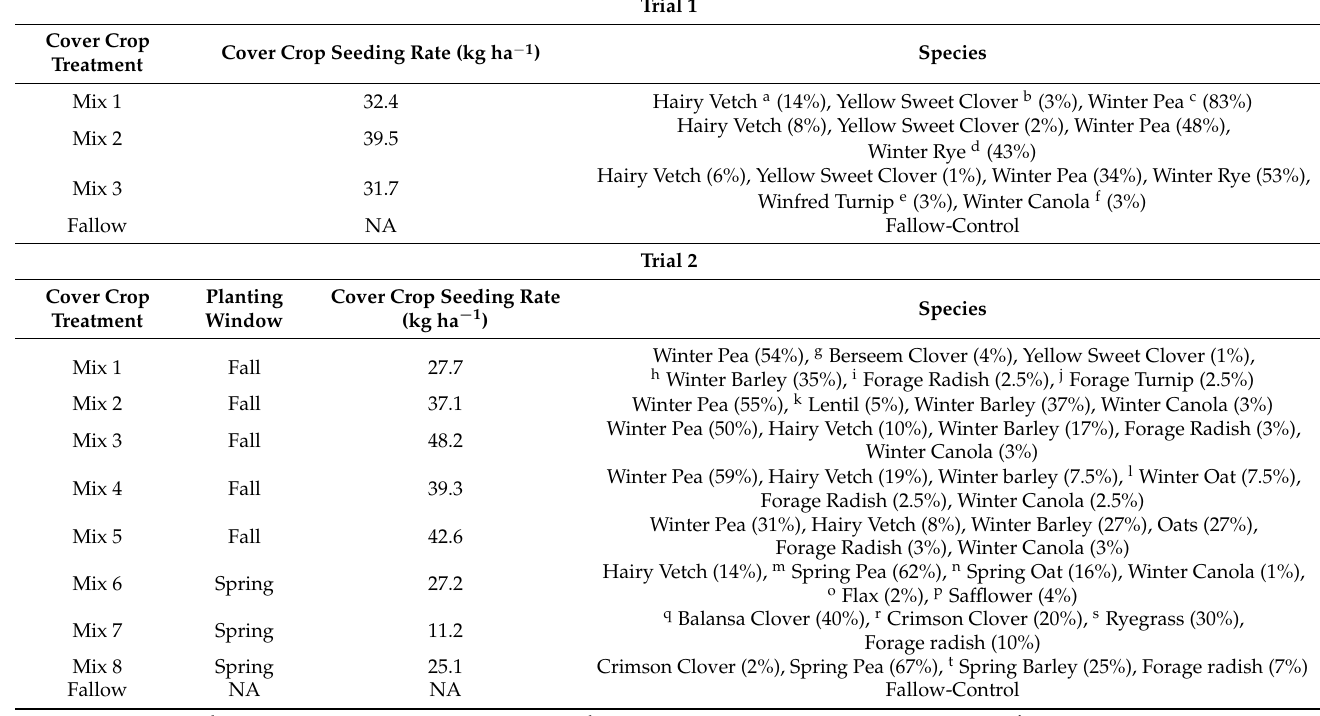
Table 1. Cover crop mixtures planted in Trial 1 and 2 at the Southwestern Colorado Research Center near Yellow Jacket, CO. Species are listed followed by percent contribution (by seed weight) in parenthesis.